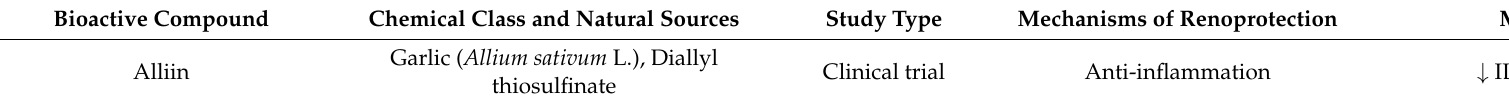
Table 1. Clinical evidence suggesting the renoprotective effects of bioactive